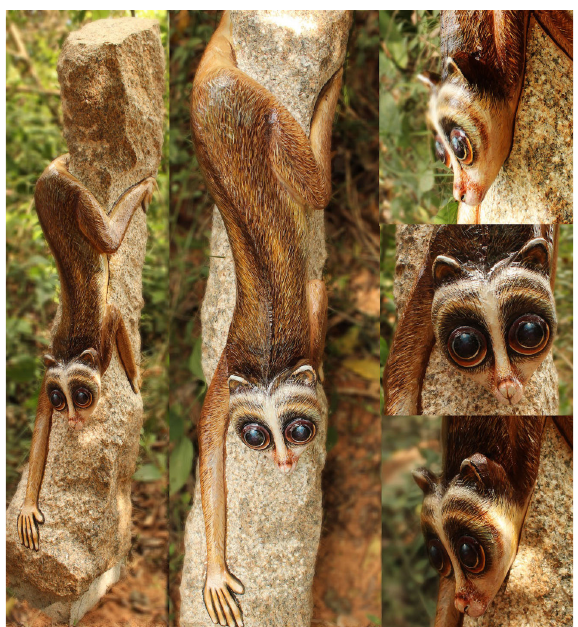
Image 12. A fine carving and finer painting of a Slender Loris Loris lydekkerianus . Every hair has been meticulously painted, and the animal is very lifelike. Pitchandikulam,